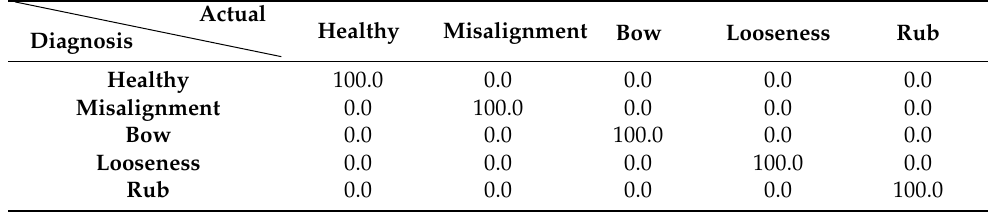
Table 3. Performance (%) obtained in blind test of VML fault detection model, using data generated at 2400 RPM in the FE model.